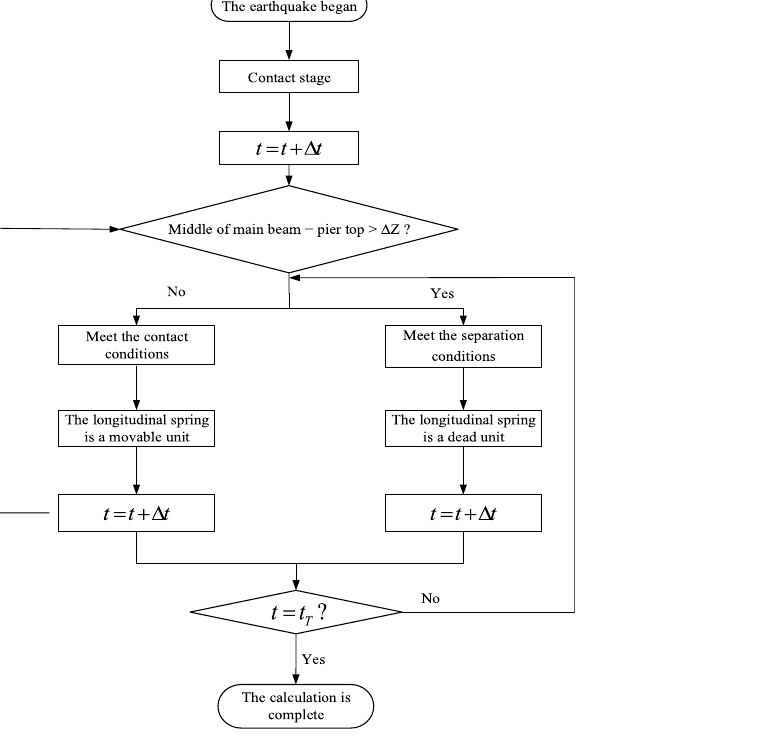
Figure 12. Flow chart of finite element